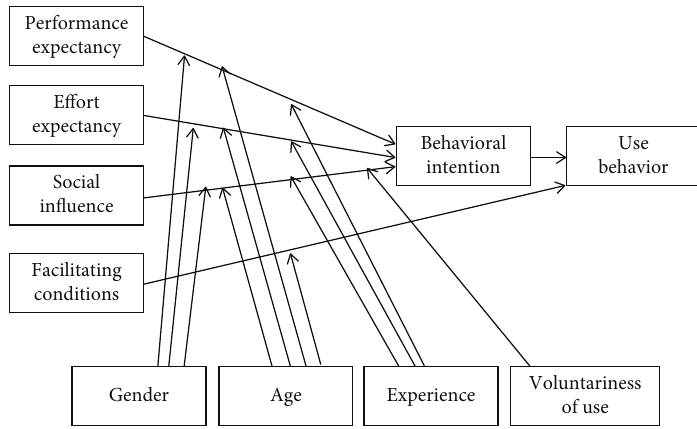
Figure 14: Uni fi ed theory of acceptance and use of technology (UTAUT)